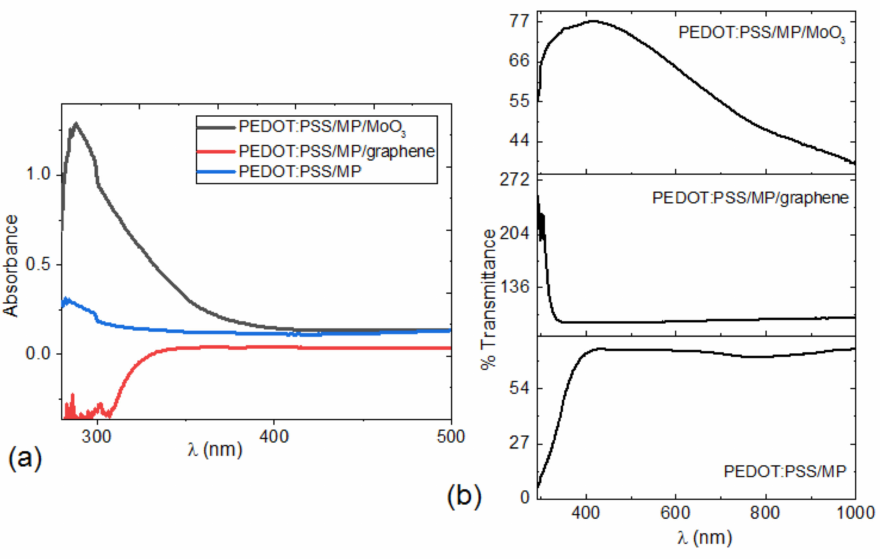
Figure 9. ( a ) Absorbance and ( b ) transmittance spectrum of hybrid